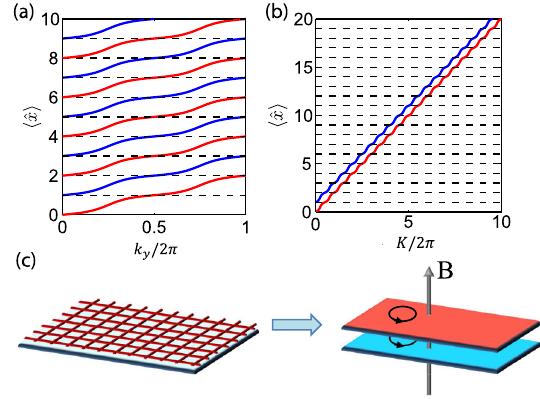
FIG. 1. (a) Each state shifts over two lattice spacings: h ^ x i ! ! k þ 2 (cid:1) . Thus, there are two families of states h ^ x i þ 2 , as k y y (red and blue lines). (b) The states can be mapped to two families of states, each parametrized by a single parameter K (c) Illustration of the fact that the Chern-number-2 lattice system is mapped to a bilayer quantum Hall system, with the two layers corresponding to the two families of Wannier states shown in panel